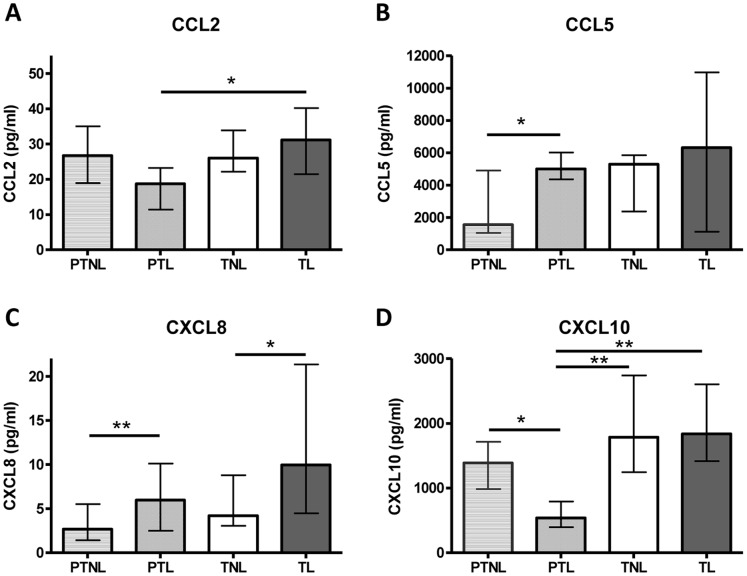
Chemokine concentrations in plasma from women in preterm and term labour.(A) CCL2, (B) CCL5, (C) CXCL8, (D) CXCL10. Individual replicates and the median are shown, n = 6–10/study group. PTNL = Preterm not in labour, PTL = Preterm labour, TNL = Term not in labour, TL = Term labour. Data are median and interquartile range, *p<0.05, **p<0.01 (Kruskall-Wallis with Dunn’s post hoc test).